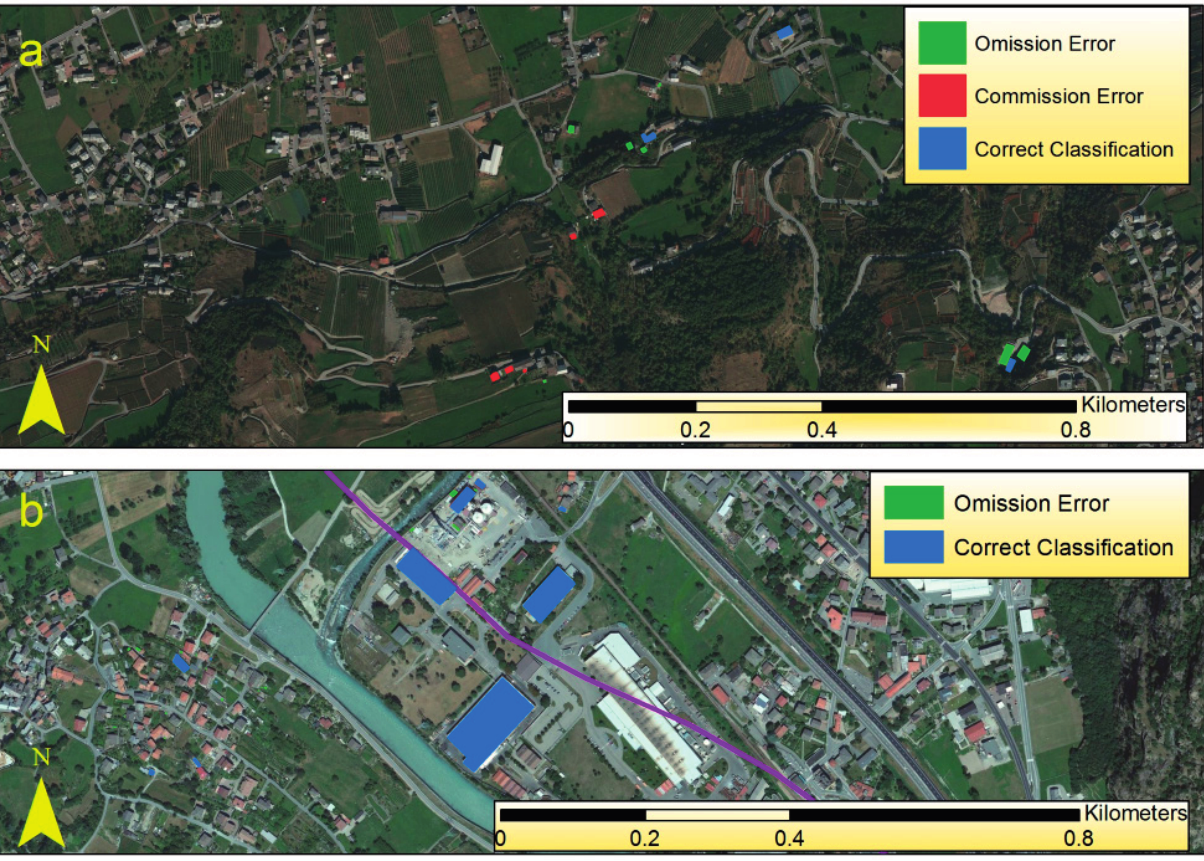
Figure 4. Examples of asbestos-cement roofs correct detection (blue polygons), commission error (red polygons) and omission error (green polygons). ( a ) Residential area between Gressan and Charvensod; ( b ) Industrial area between Verres and Issogne.